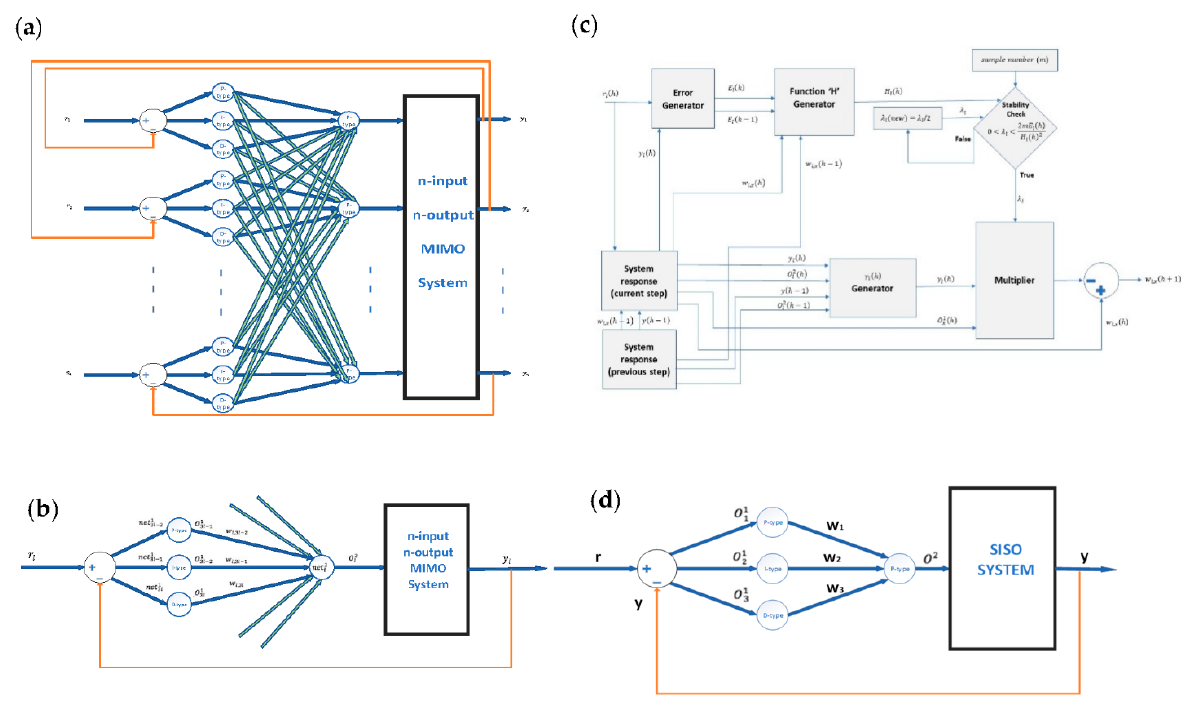
Figure 1. ( a ) Structure of the proposed MANN, ( b ) S-MANNC structure, ( c ) flowchart of real-time simultaneous stability criteria check and weight adjustment algorithm for MANNC, and ( d ) applying MANNC to a SISO system.